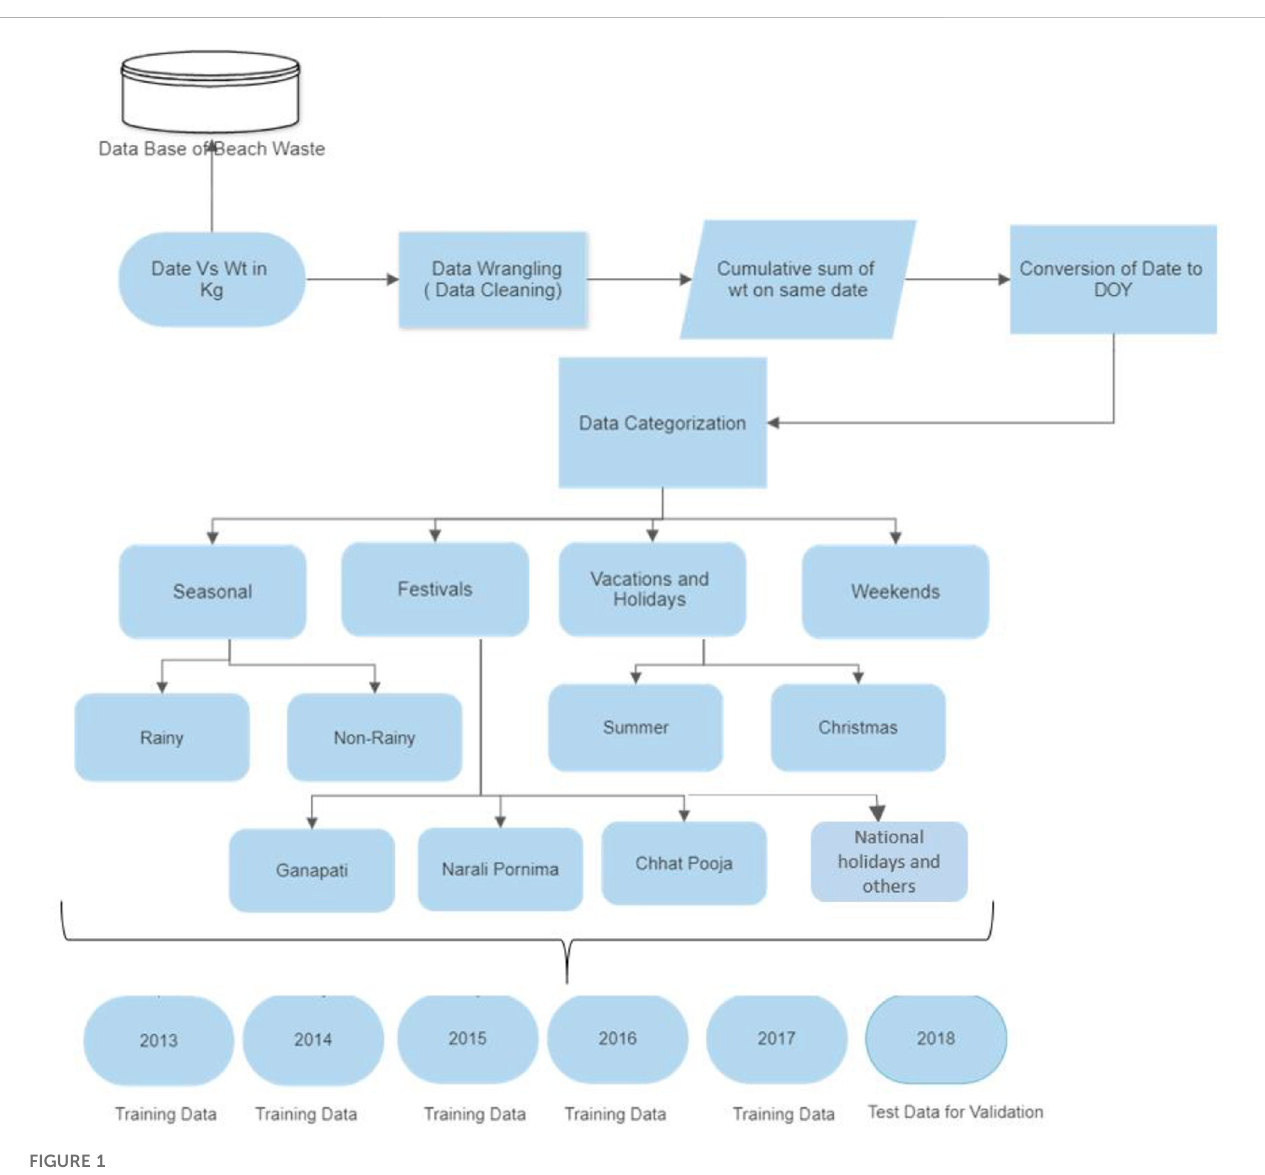
FIGURE 1 Process fl ow for data analysis and